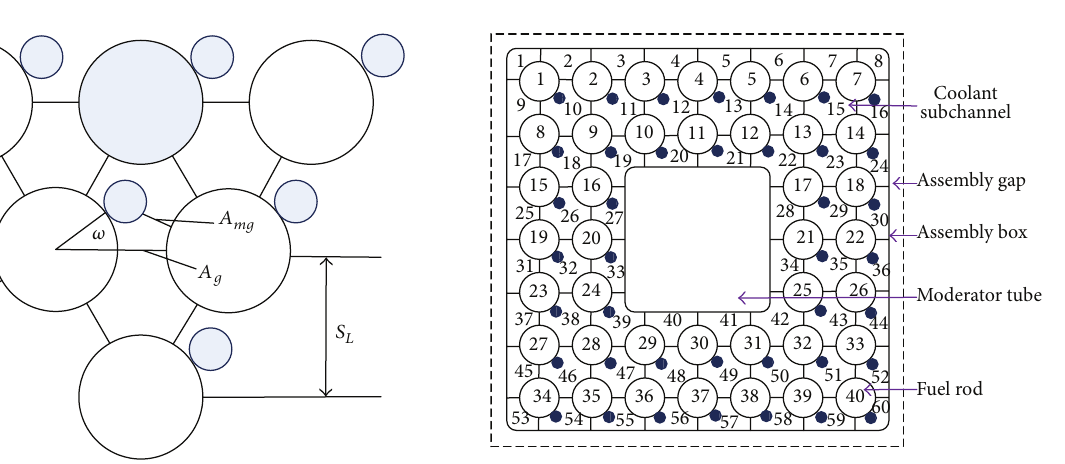
Figure 3: Average wire wrap position and gap definition.